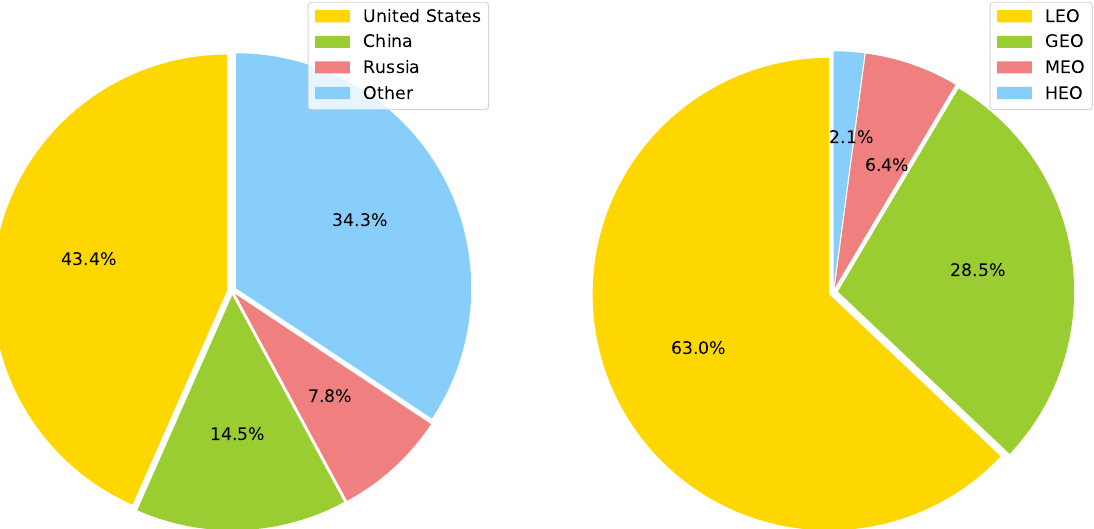
Figure 2. Active Earth orbiting satellites, separated by country of origin and type of orbit, from a total of 1957 active satellites reported until 30th November 2018. Data published by the Union of Concerned Scientists (UCS) in its annual report